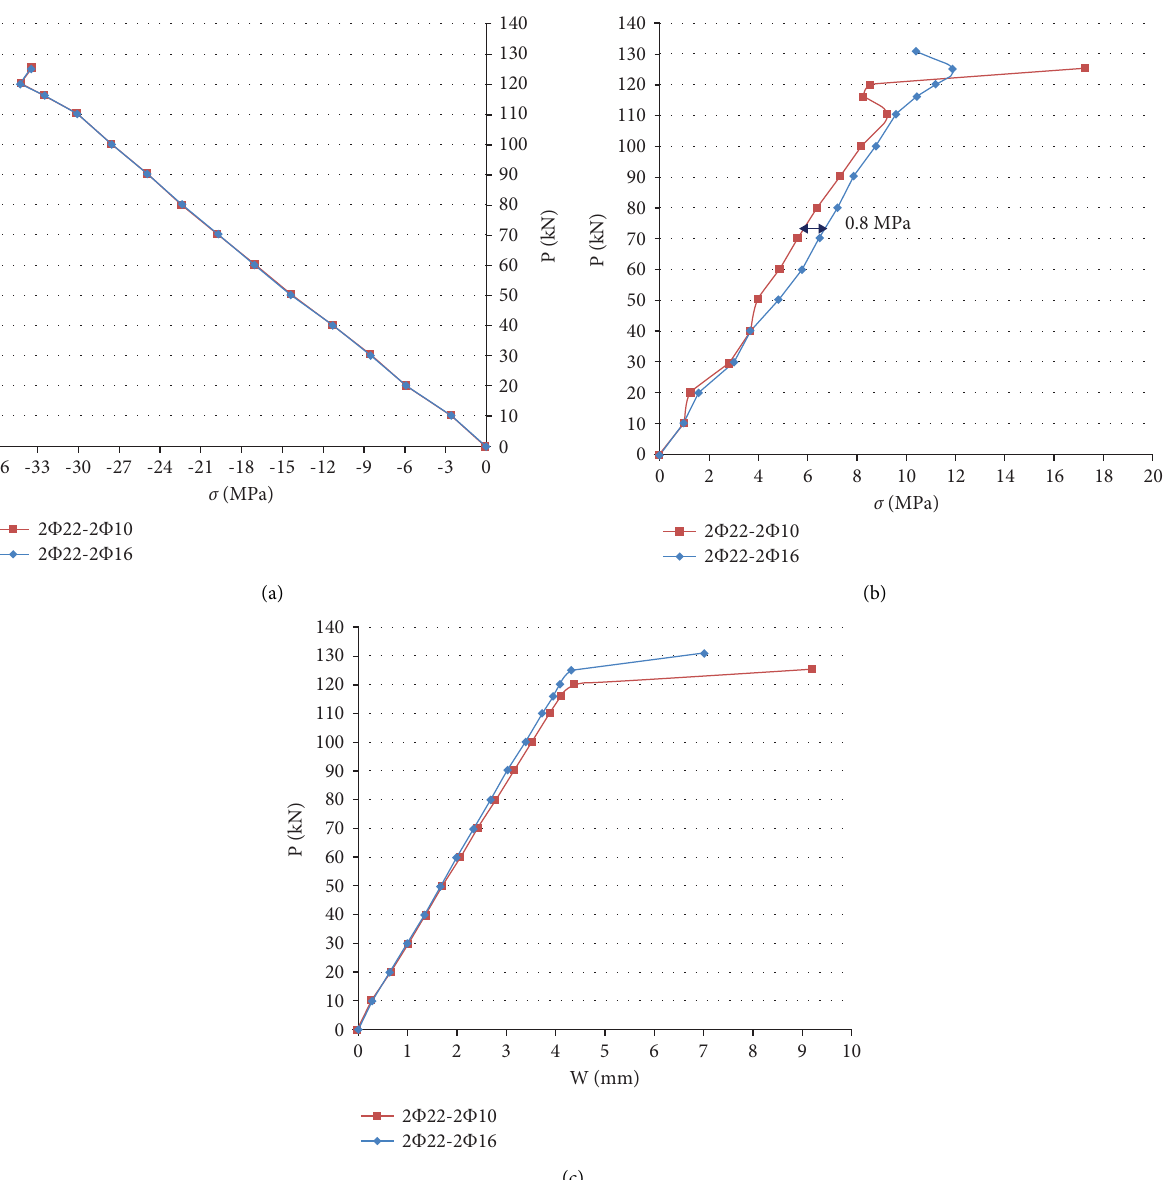
Figure 22: Relationship betweenloadand stress,aswell asbetweenload andvertical displacement(efect ofthediameterof compressedsteelbars): (a) relationship between load and compressive stress, (b) relationship between load and tensile stress. (c) the relationship between load and